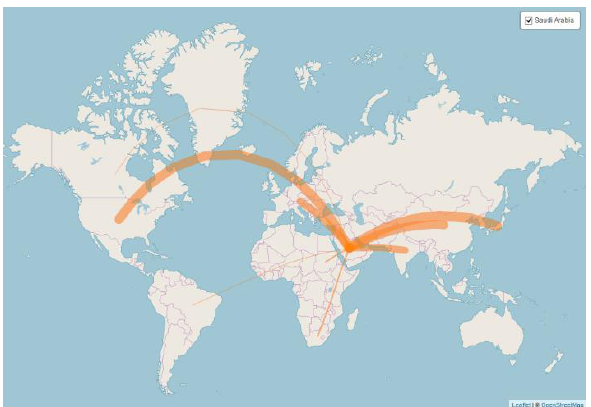
Figure 9. Export of crude oil from Saudi Arabia.